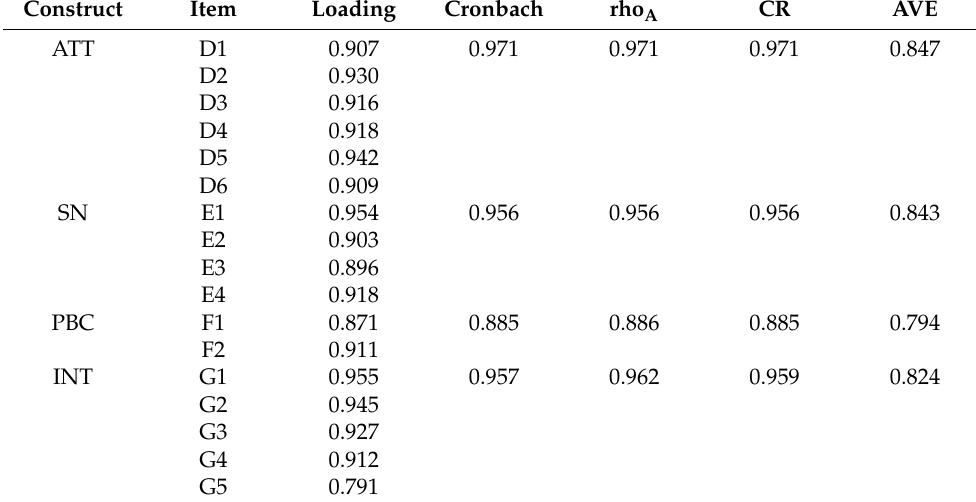
Table 1. Convergent validity